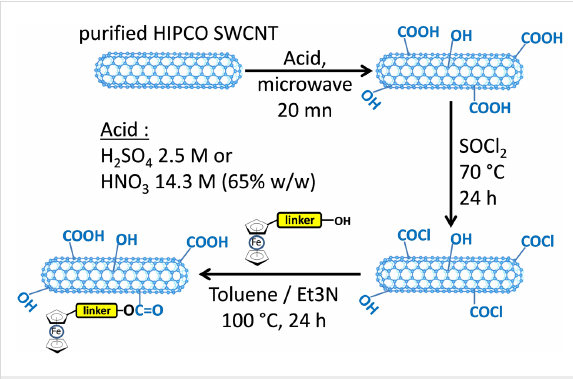
Figure 3: Three-step covalent functionalization of HIPCO SWCNTs using different acidic conditions for step